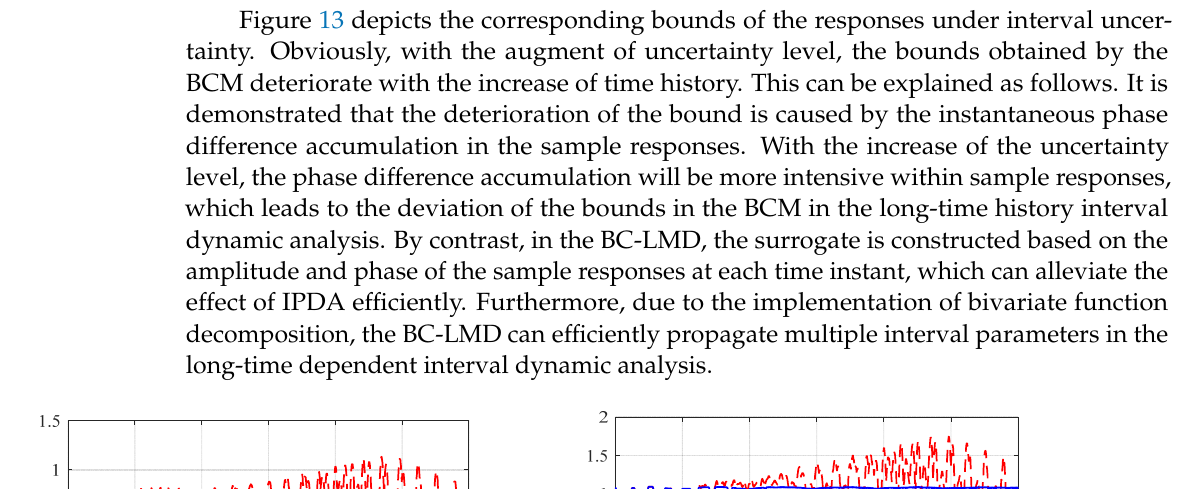
Figure 12. Lower bound of the double pendulum under a 1% uncertainty level: ( a ) lower bound of the rotation angle of the top rod; ( b ) lower bound of the rotation angle of the bottom rod.